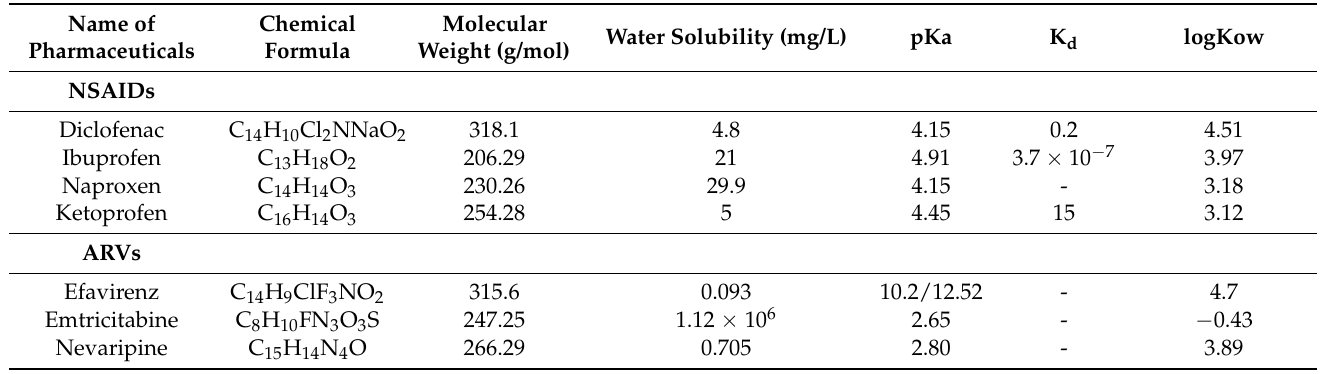
Table 1. Physiochemical properties of NSAIDs and ARV drugs present in